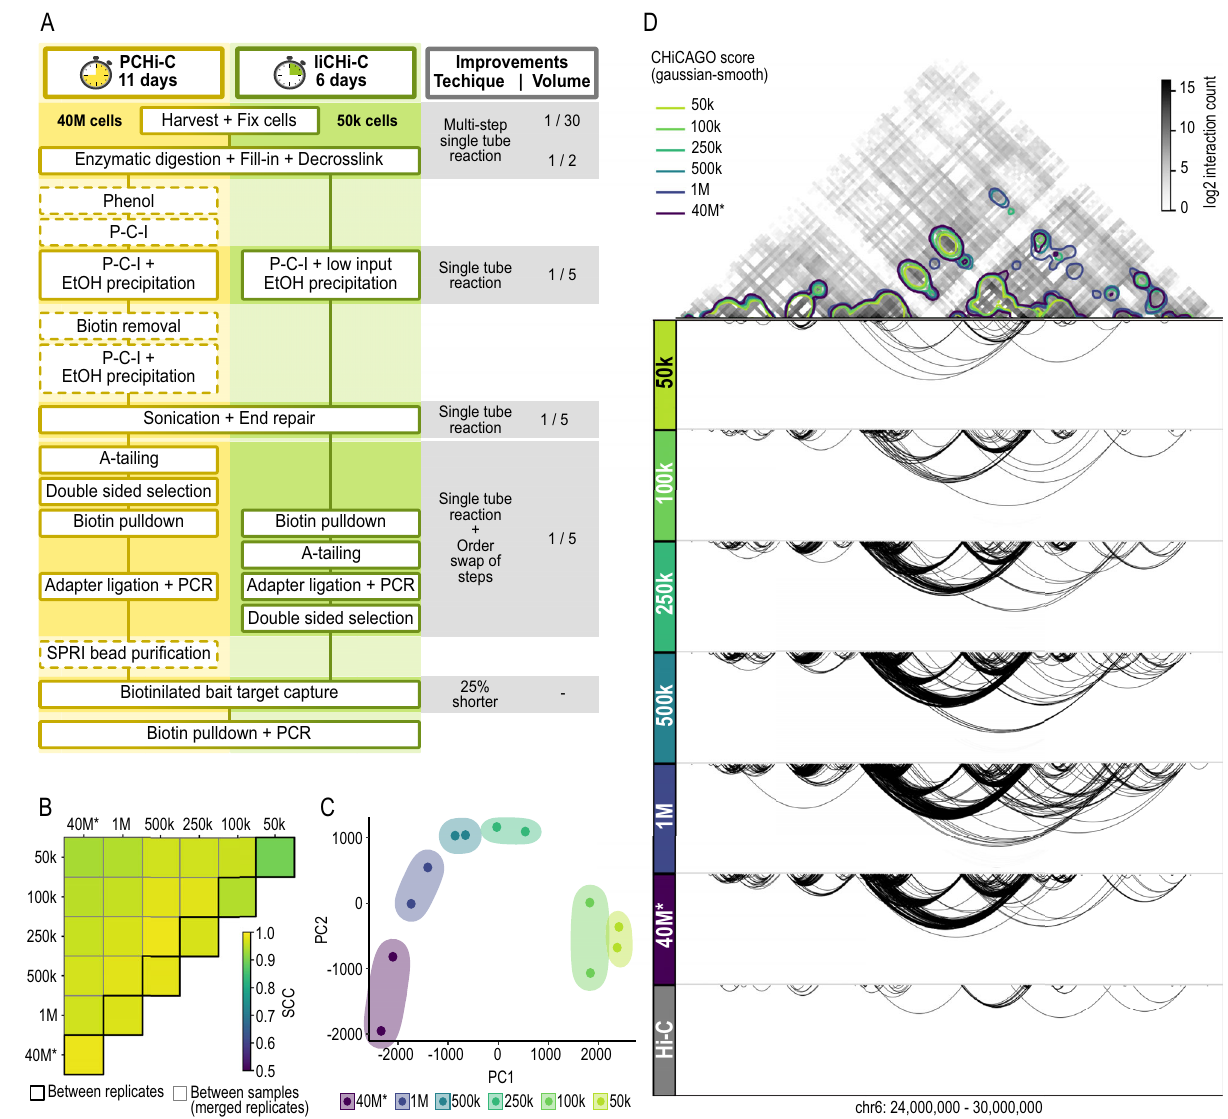
Fig. 1 | liCHi-C is a robust and reproducible method to study the promoter interactomeinlow-abundancecellpopulations.A Schematiccomparisonofthe PCHi-C vs liCHi-C work fl ow. Dash-bordered boxes denote removed steps from the original PCHi-C protocol. B Heatmap displaying stratum-adjusted correlation coef fi cient(SCC) between promoter interactomesof humannaive B cells obtained by liCHi-C and PCHi-C (*) using different cell numbers at 100kb resolution. Reproducibility between biological replicates and between pairs of merged biolo- gical replicates are surrounded by black and gray lines, respectively. k 1000, M